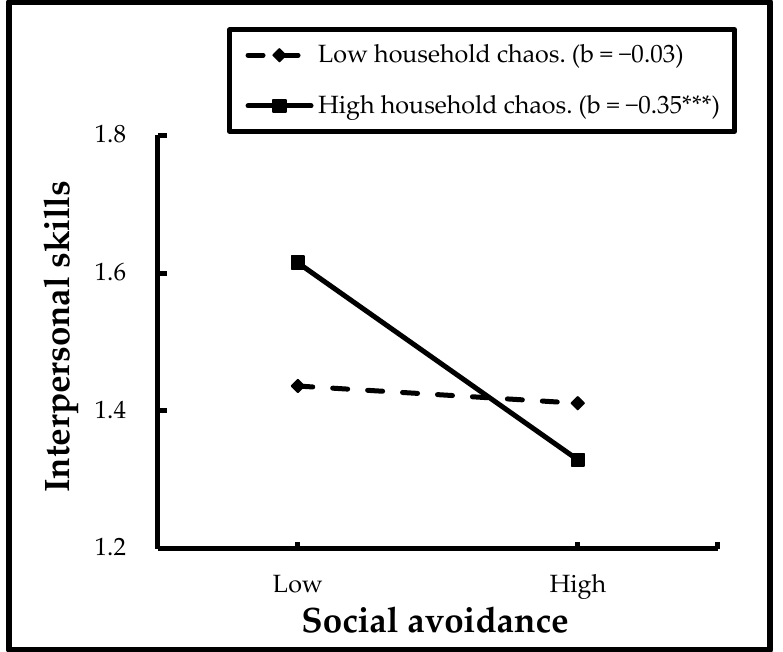
Figure 2. Interactions between social avoidance and household chaos in predicting interpersonal skills. *** p < 0.001.